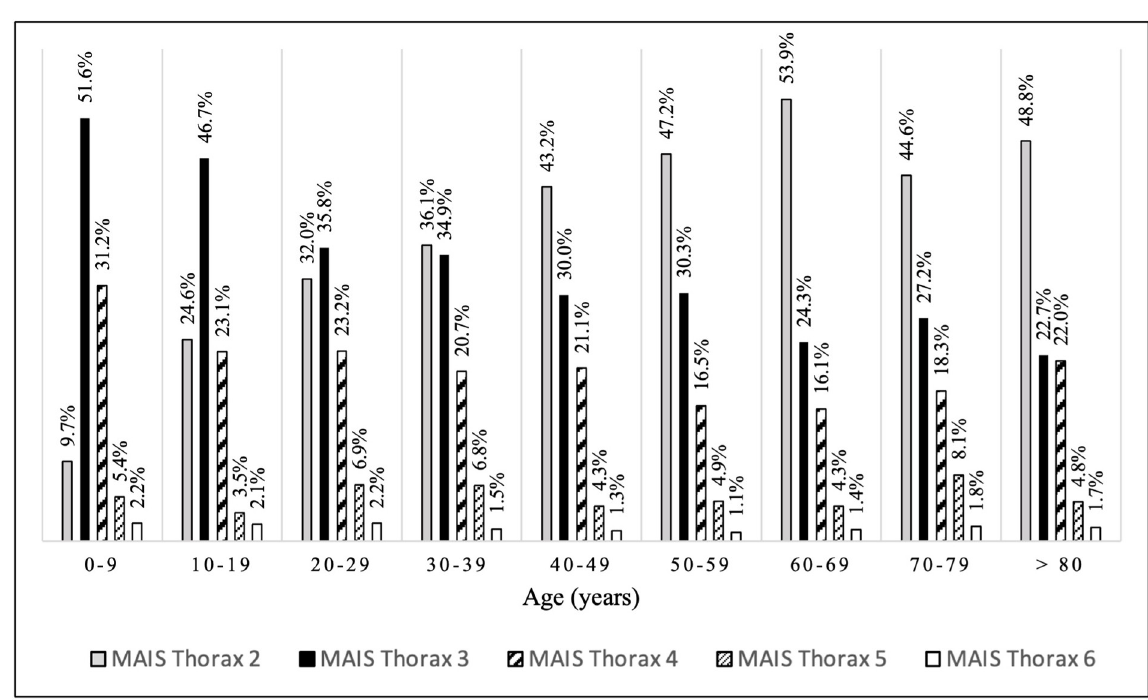
Fig 3. Thoracic MAIS distribution among the AIS Thorax � 2 group. Subgroups according to the age. AIS Thorax � 2 group: trauma patients presenting with at least one thoracic injury AIS � 2. AIS: abbreviated injury scale. MAIS: maximum abbreviated injury scale.